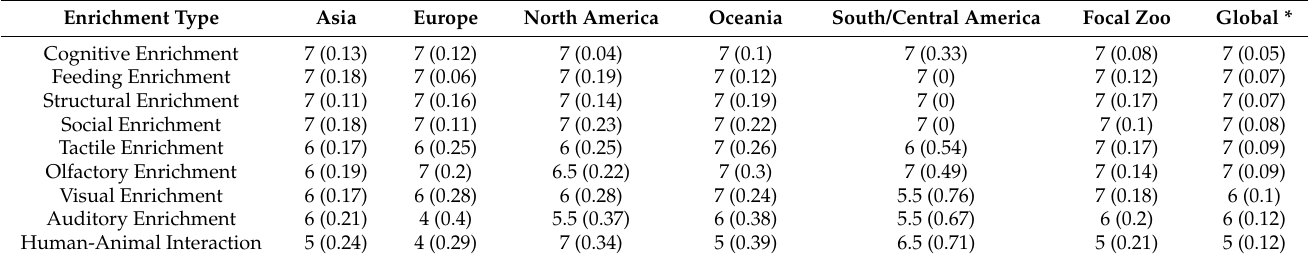
Table 3. Median response to “How important do you think the following types of enrichment are to the welfare of captive animals?”. Responses were categorized by region, using a Likert scale of 1–7: 1 = Not important and 7 = very important. Standard error is presented in